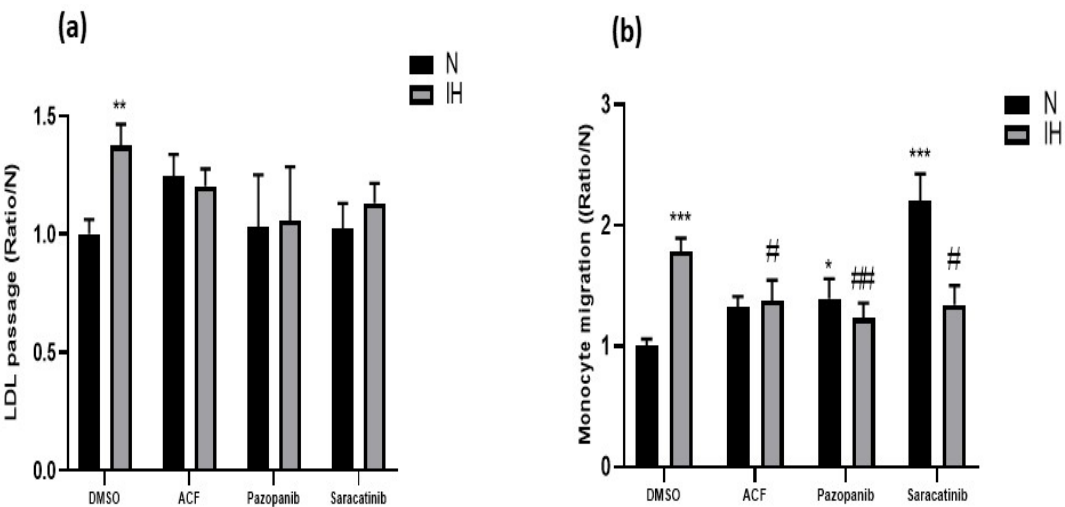
Figure 1. IH-induced increases in transendothelium passage of LDL and monocytes in vitro are prevented by inhibitors of VE-cadherin cleavage. ( a ) Inhibiting HIF-1 by acriflavine, Src-kinases by saracatinib and VEGF receptor tyrosine kinases by pazopanib, prevented the IH-induced increase in transendothelium passage of LDL (2-way ANOVA, ** p < 0.01 vs. N + DMSO, n = 28 for DMSO, n = 8–12). ( b ) Inhibiting HIF-1 by acriflavine, Src-kinases by saracatinib and VEGF receptor tyrosine kinases by pazopanib prevented the IH-induced transendothelium migration of monocytes (2-way ANOVA, * p < 0.05 and *** p < 0.001 vs. N + DMSO, # p < 0.05 and ## p < 0.01 vs. IH + DMSO, n = 10–